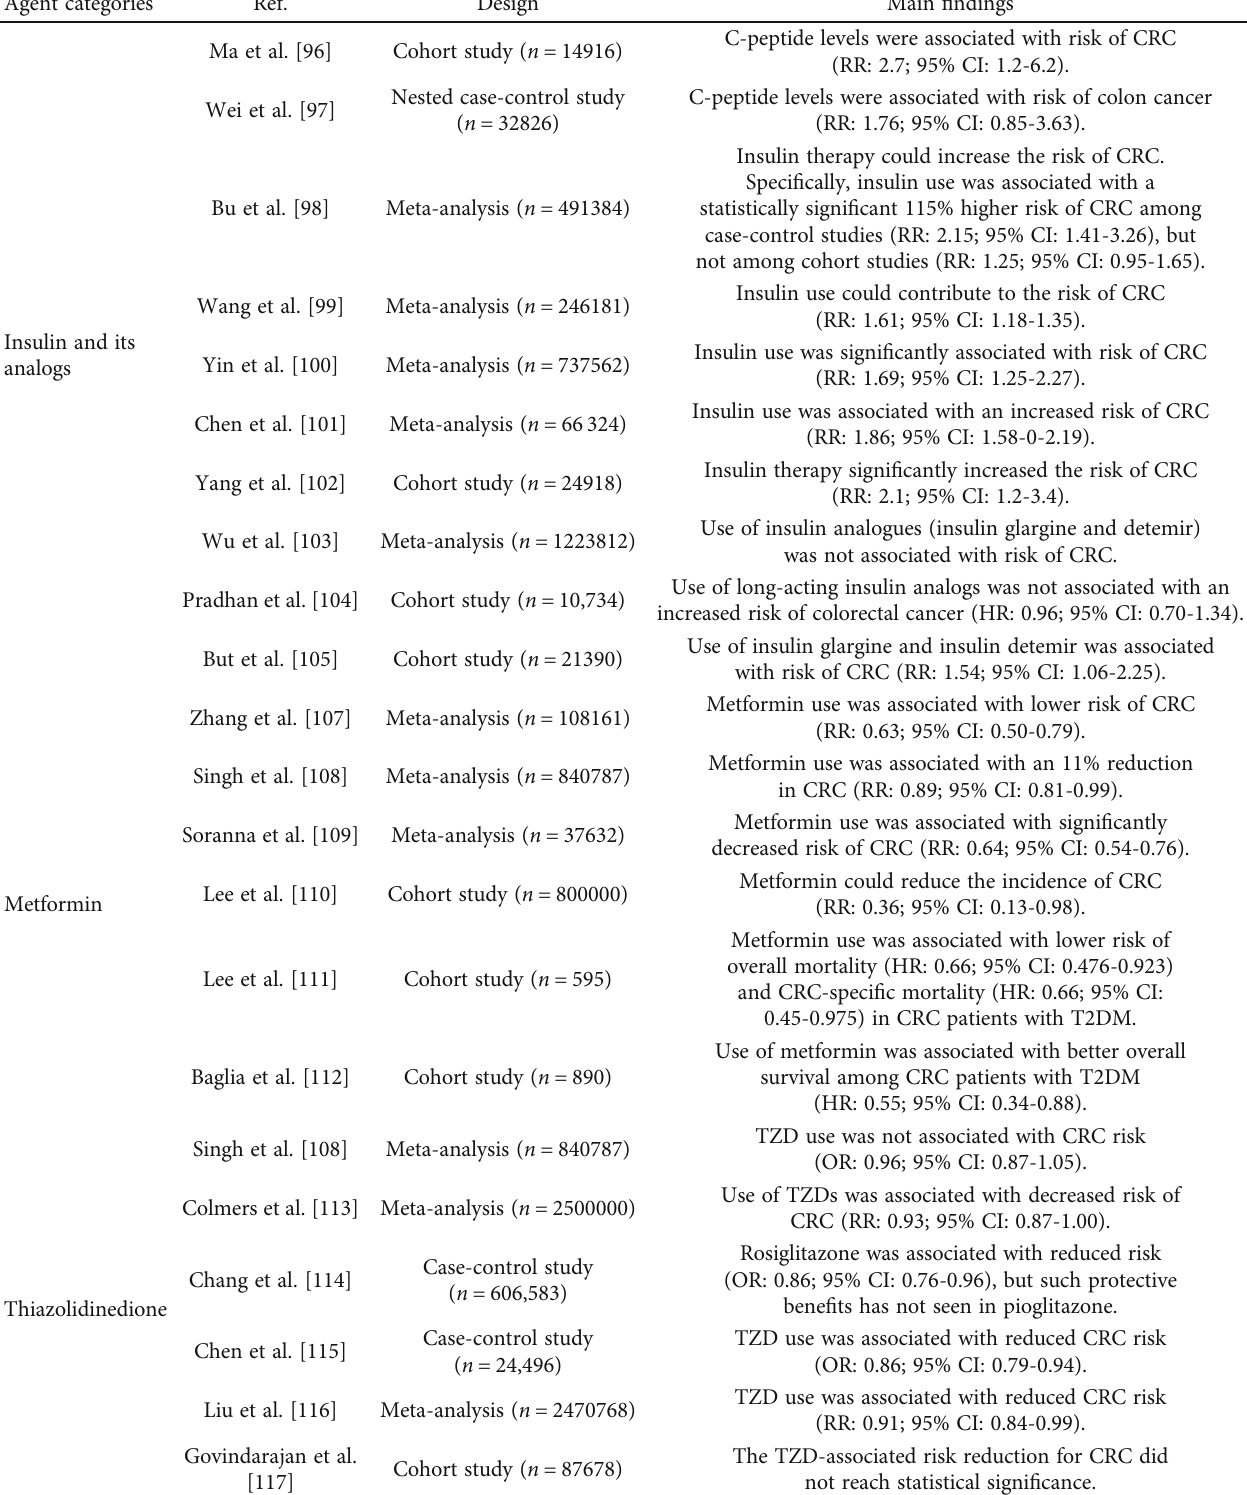
Table 3: Nonexhaustive summary of associations between the use of hypoglycemic medications (insulin, insulin analogs, metformin, thiazolidinediones, sulfonylurea, and α -glucosidase inhibitor) and the risk of CRC. Agent